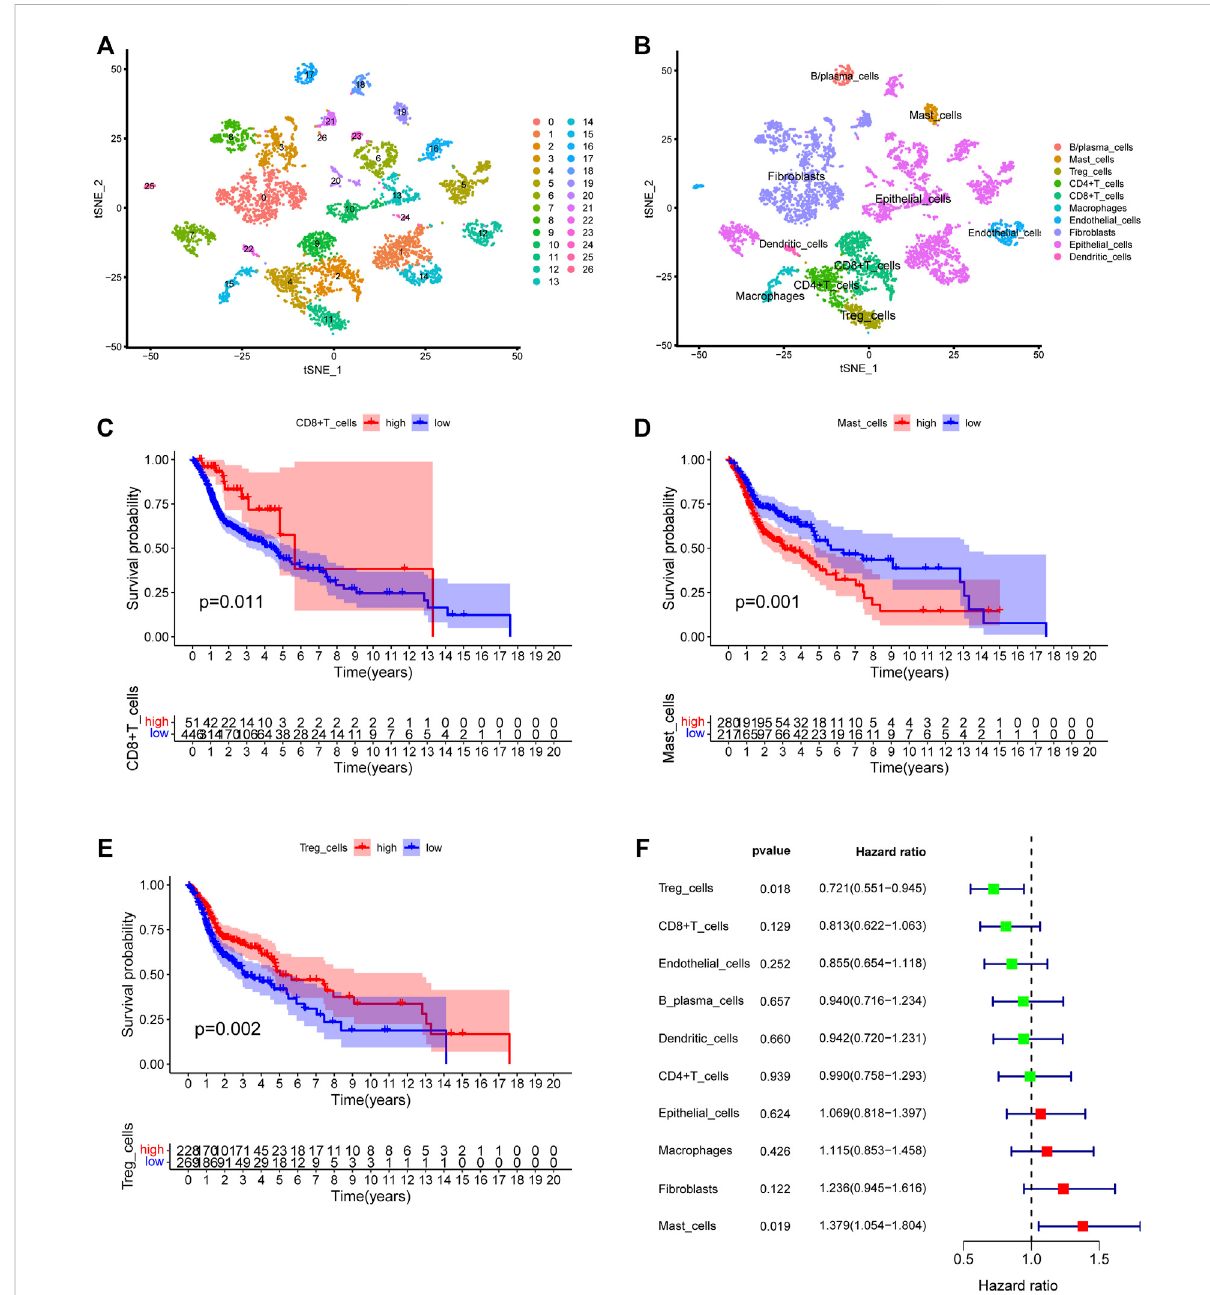
FIGURE 2 Identi fi cation of the HNSCC-associated cell subtypes. (A) t-SNE plot classi fi ed cell clusters based on scRNA sequencing data. (B) t-SNE plot identi fi ed the various cell subtypes. (C – E) Kaplan-Meier survival analysis of three cell subtypes using the deconvolved TCGA data. (C) CD8 + T cells: p = 0.011, (D) Mast cells: p = 0.001, (E) Treg cells: p = 0.002. (F) Univariate analysis of ten cell